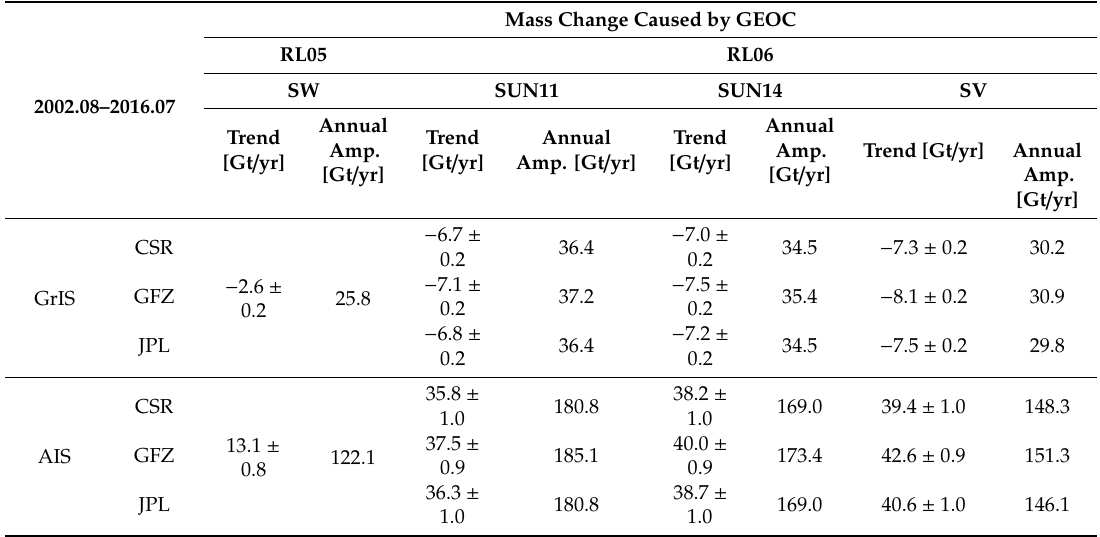
Table 2. The linear trend and annual amplitude (Amp.) of mass change time series caused by GEOC or degree one terms over the GrIS and the AIS during the time span from August 2002 to July 2016, using degree one terms corresponding to GRACE RL05 and RL06 data published by CSR, GFZ, and